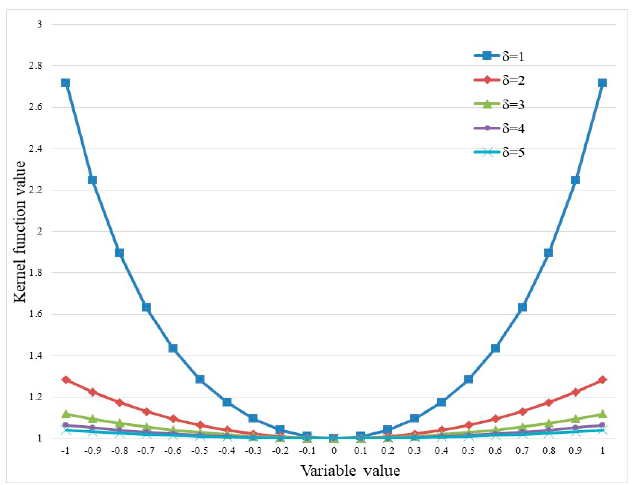
Figure 4. The data distribution characteristics of the RBF kernel function.